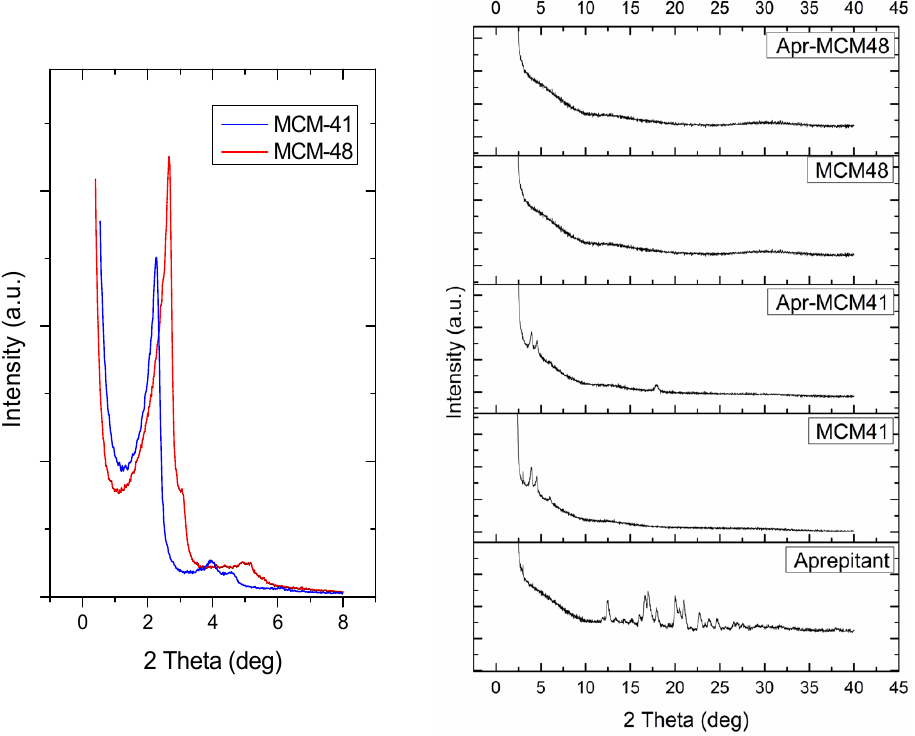
Figure 5. Small angle Powder X-ray Diffractometry (pXRD) patterns ( left ) of pristine MSN particles and wide angle pXRD patterns ( right ) of the samples in the presence and absence of aprepitant.